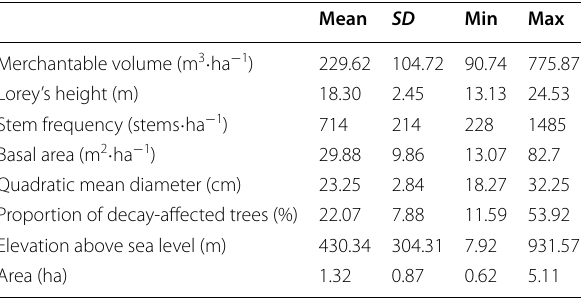
Table 1 Means, standard deviations (SD), minimums (min), and maximums (max) of attributes associated with the harvested segments ( n 101) = Mean SD Min